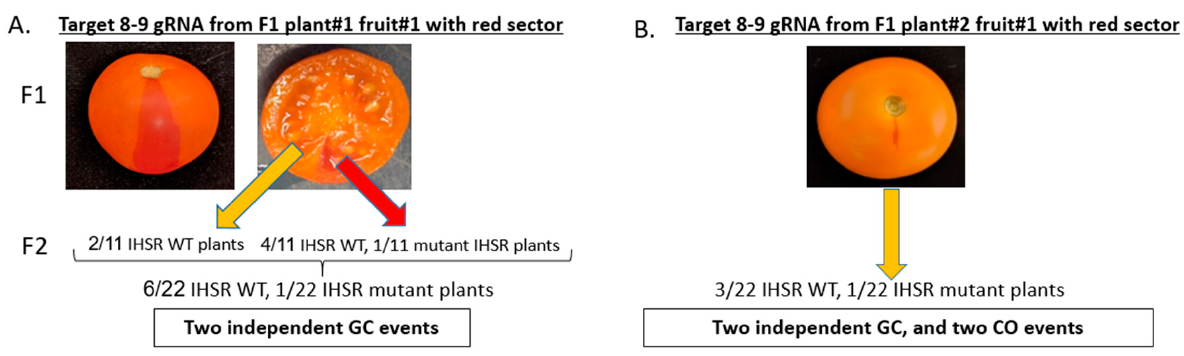
Figure 4. CRTISO target 8–9 induces IHSR events. Red sector fruits indicating late IHSR event, were detected in CRTISO DSB target 8–9 only. ( A ) The red sector of F 1 8–9 DSB target plant#1 fruit#1 reached the mesocarp, unlike all other smaller red sector fruits that remained in the pericarp. Seeds were collected separately from the tangerine and red WT parts of the fruit. Eleven seeds of each tangerine and red WT sector were grown. Four IHSR WT and one IHSR mutant progeny were found from the red WT sector. Two more IHSR WT progeny were found from the tangerine fruit part, leading to a total of seven IHSR progeny out of 22 F 2 plants. ( B ) The red sector of F 1 8–9 DSB target plant#2 fruit#1 was present in the pericarp only, therefore, seeds were collected as one pool. Twenty-two seeds were grown. Three IHSR WT and one IHSR double mutant progeny were found out of 22 F 2 plants.